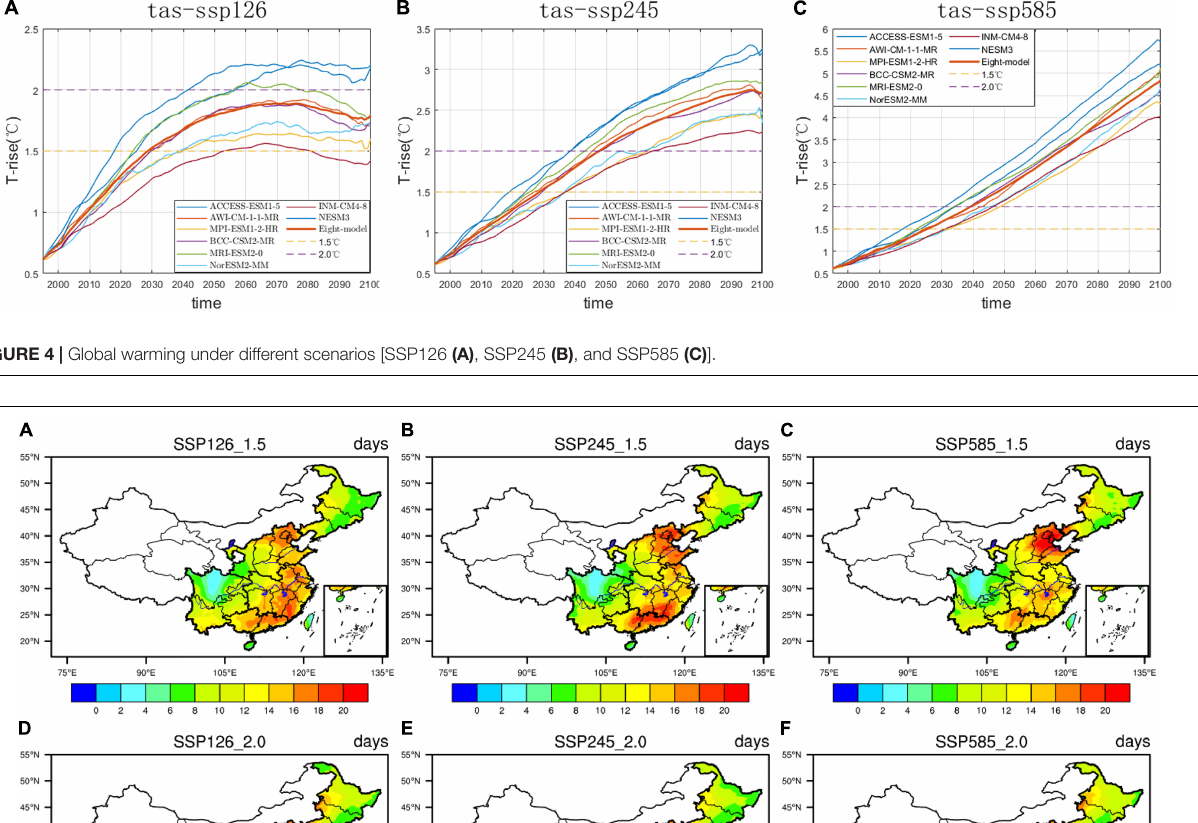
Frontiers in Earth Science |